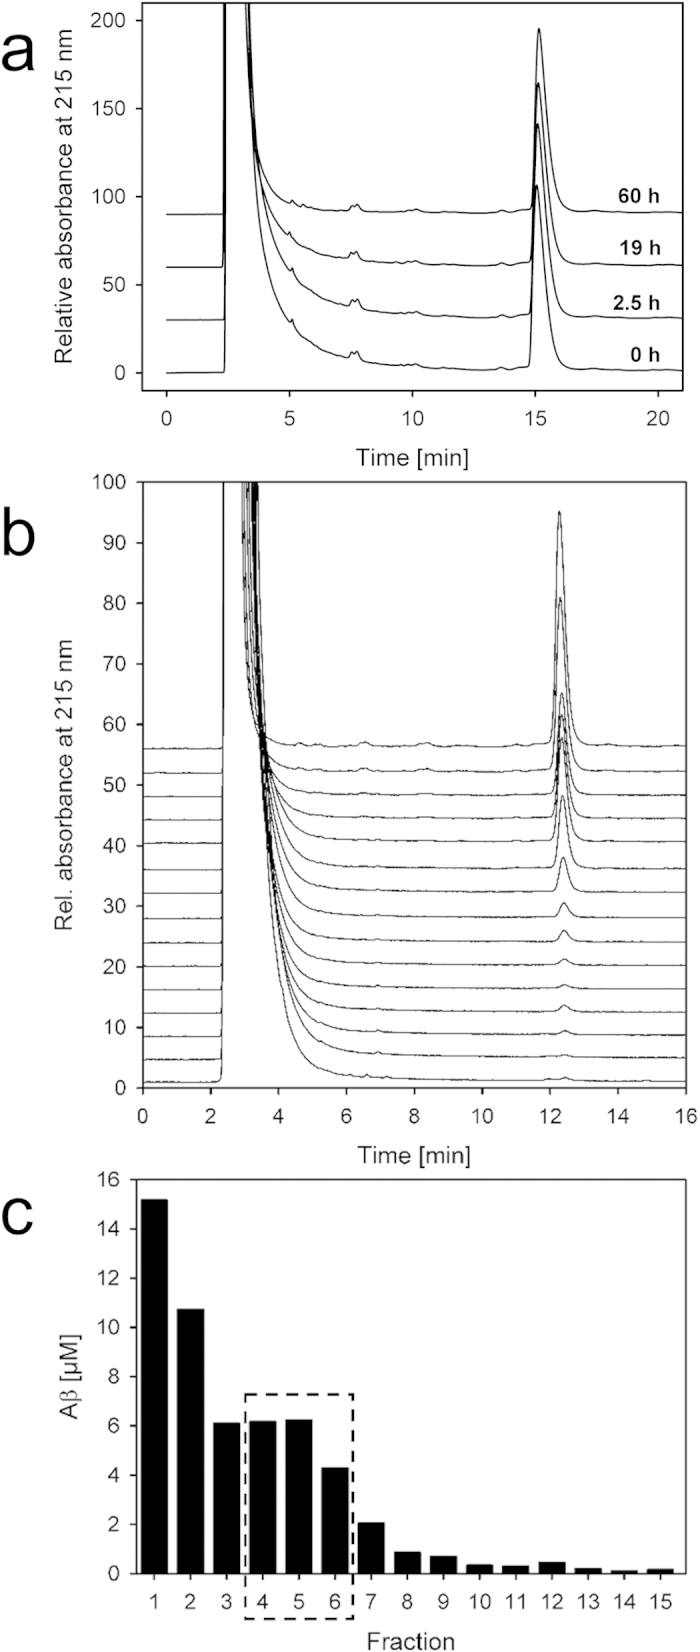
Quantification of Aβ(1–42) in different assembly states by QIAD.(a) RP-HPLC chromatograms of 1.8 ng of either freshly resolved or incubated (2.5, 19 and 60 h) Aβ(1–42) were mixed with 40% iodixanol to simulate the properties of the density gradient fractions and analysed by RP-HPLC. Iodixanol elutes clearly separated from Aβ(1–42) (retention time 2-5 min), enabling UV spectroscopic analysis of Aβ(1–42) concentrations. Chromatograms of all Aβ(1–42) samples regardless of their degree of aggregation reveal the same retention times and peak areas. (b) Chromatograms for each fraction obtained from density gradient centrifugation (DGC) are presented with a constant offset for clarity. The peak at 2 to 4 min corresponds to the density gradient material iodixanol, whereas the peak at 12.5 min corresponds to Aβ(1-42). (c) Bar chart showing the Aβ(1–42) distribution after DGC of pre-incubated Aβ(1–42). Aβ(1–42) concentrations in each fraction were determined by integration of the Aβ(1–42) absorption in the RP-HPLC chromatograms shown in (b). Aβ(1-42) oligomers of interest (dashed box) are located in fractions 4 to 6.